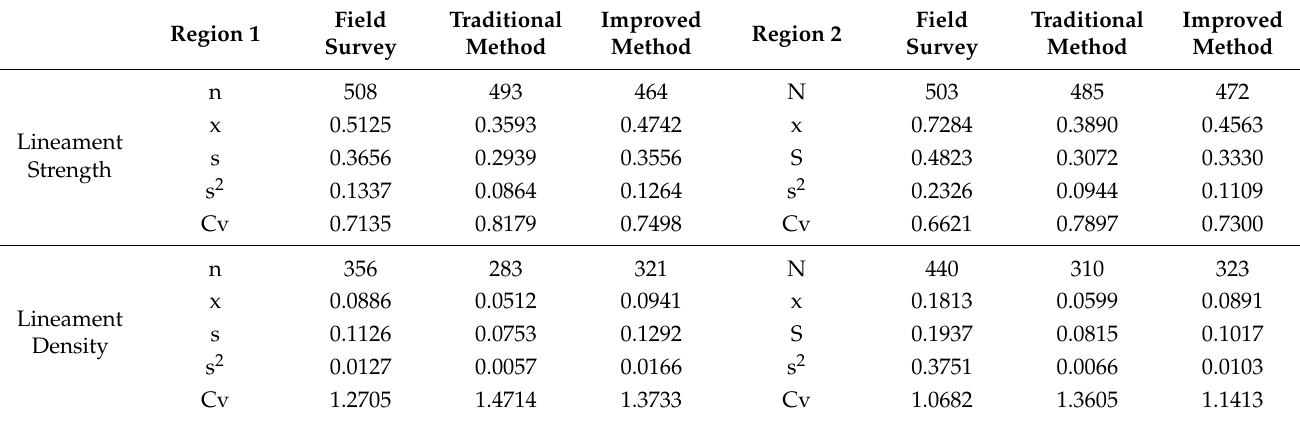
Figure 17. Digital lineament strength and density map. Lineaments extracted from study area 1 and 2 by the improved line tracking method (n represents the number and intersections of lineaments). Table 2. Lineament strength and density with the three